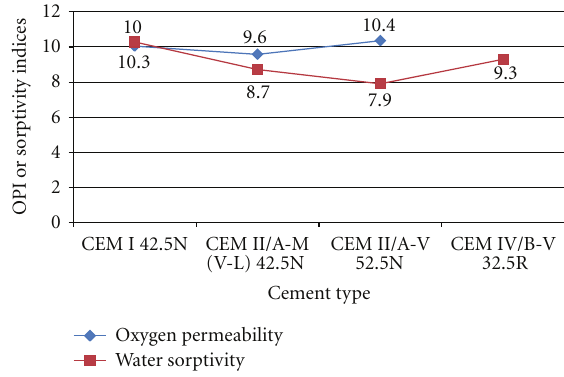
Figure 6: OPI and water sorptivity indices for di ff erent cement types at a w/c ratio of